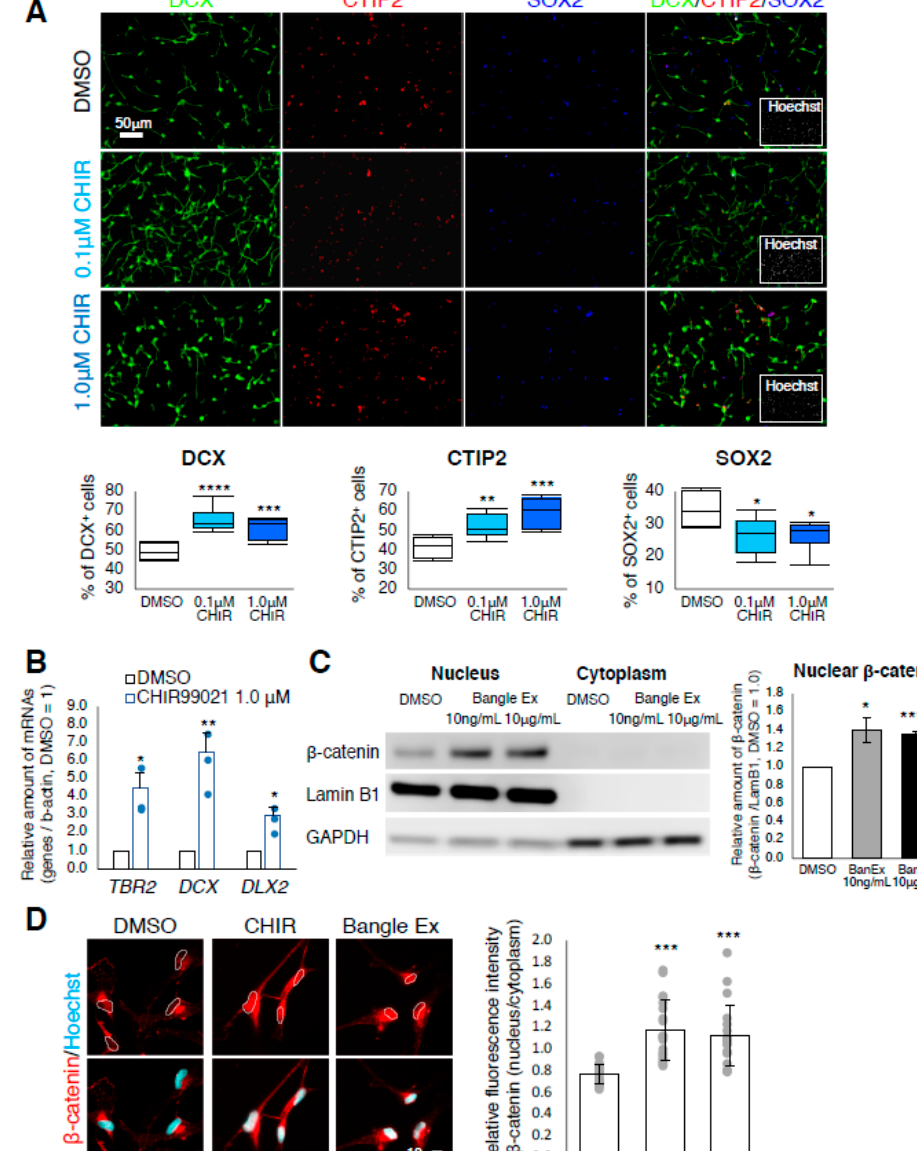
Figure 3. Treatment with the WNT signaling activator CHIR99021 promotes neuronal di ff erentiation of hfNSCs. ( A ) Cells treated with or without CHIR99021 were stained with several antibodies 7 days after induction of di ff erentiation. Scale bar: 50 µ m. The graphs indicate the percentage of total cells that were DCX-, CTIP2-, or SOX2-positive. The values shown are the means ± SD. ( N = 6, t -test, * p < 0.05, ** p < 0.01, *** p < 0.005, **** p < 0.001). ( B ) Quantitative RT-PCR analysis of the cells 2 days after the induction of di ff erentiation. Data represent mean ± SEM, when compared with control cells. ( N = 3, t -test, * p < 0.05, ** p < 0.01). Blue dots represent the value from individual experiments. ( C ) Western blot analysis of nuclear and cytoplasmic β -catenin expression in 10 ng / mL and 10 µ g / mL Bangle extract-treated hfNSCs. LaminB1 and GAPDH were used as nuclear and cytoplasmic fraction markers, respectively. In the graphs, the values of nuclear β -catenin derived from ImageStudio Digits were normalized by LaminB1. The relative amounts are the means ± SEM compared with those for DMSO treatment. ( N = 3, t -test, * p < 0.05, **** p < 0.001). ( D ) The cells treated with 10 µ M CHIR99021 and 10 ng / mL Bangle extract for 2 days were stained with antibodies against β -catenin (red) and Hoechst (nucleus: cyan). Scale bar: 10 µ m. Quantification of the ratio of fluorescence intensity of nuclear β -catenin to that of cytoplasm. The values represent the means ± SD. ( N = 20, t -test, *** p < 0.005). Grey dots represent the value from individual